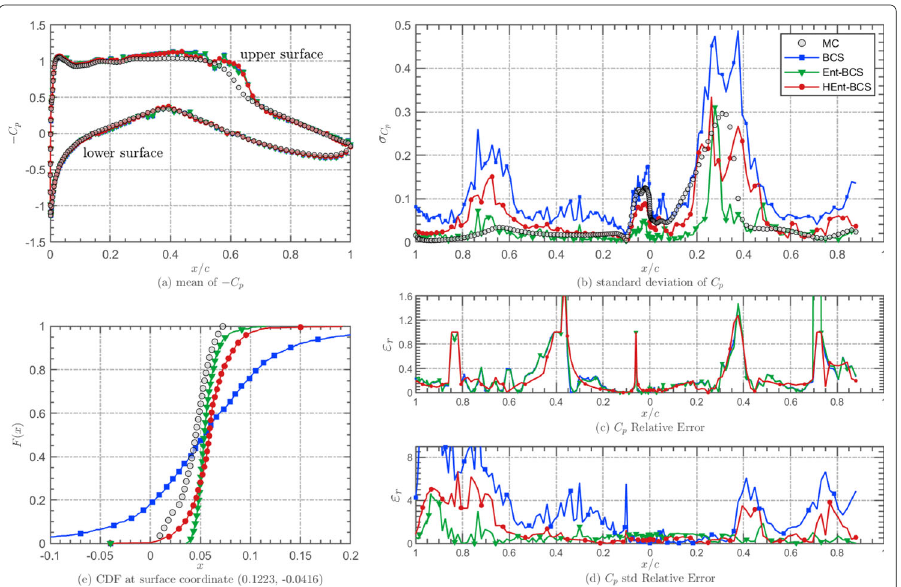
Fig. 17 Performance comparison of BCS, Ent-BCS and HEnt-BCS w.r.t. the RAE2822